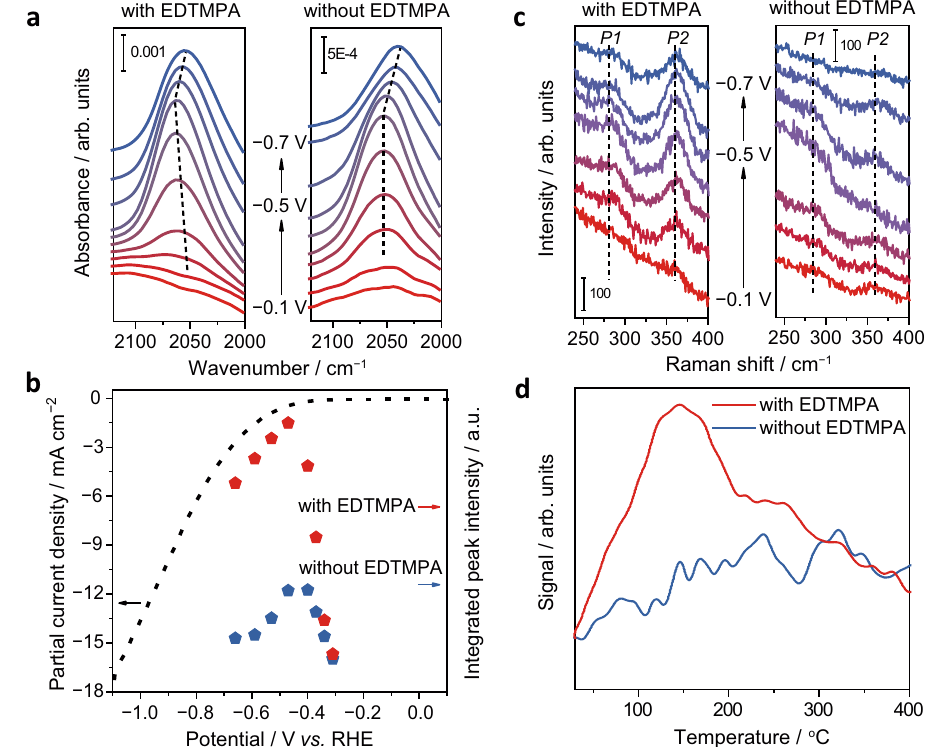
Fig. 3 Function characterization of Cu(110) surfaces. a In-situ ATR-SEIRAS spectra of a poly-Cu-coated Si ATR crystal at potentials from − 0.1 to − 0.7V versus RHE in CO 2 -saturated 0.5M KHCO 3 solutions with and without EDTMPA. b Cathodic scan curve and comparison of the integrated CO band intensities at potentials from − 0.3 to − 0.7V versus RHE as shown in a . c In-situ Raman spectra of poly-Cu at potentials from − 0.1 to − 0.7V versus RHE in CO 2 -saturated 0.5M KHCO 3 solutions with and without EDTMPA. d CO TPD pro fi les of the poly-Cu electrodes after electrocatalysis in electrolytes with and without